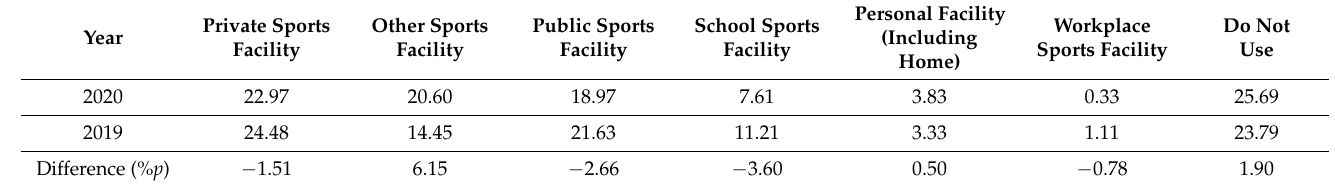
Table 3. Use of sports facilities in the residential area by year (total, unit: %, % p